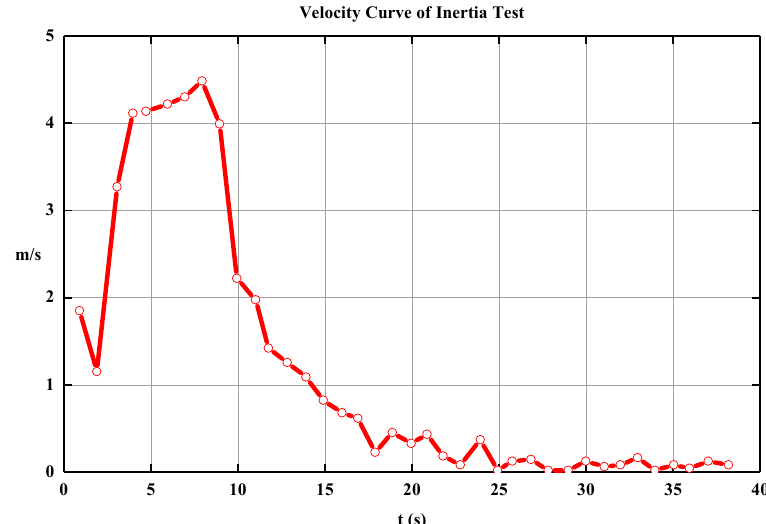
Figure 4. Velocity curve of inertia test.